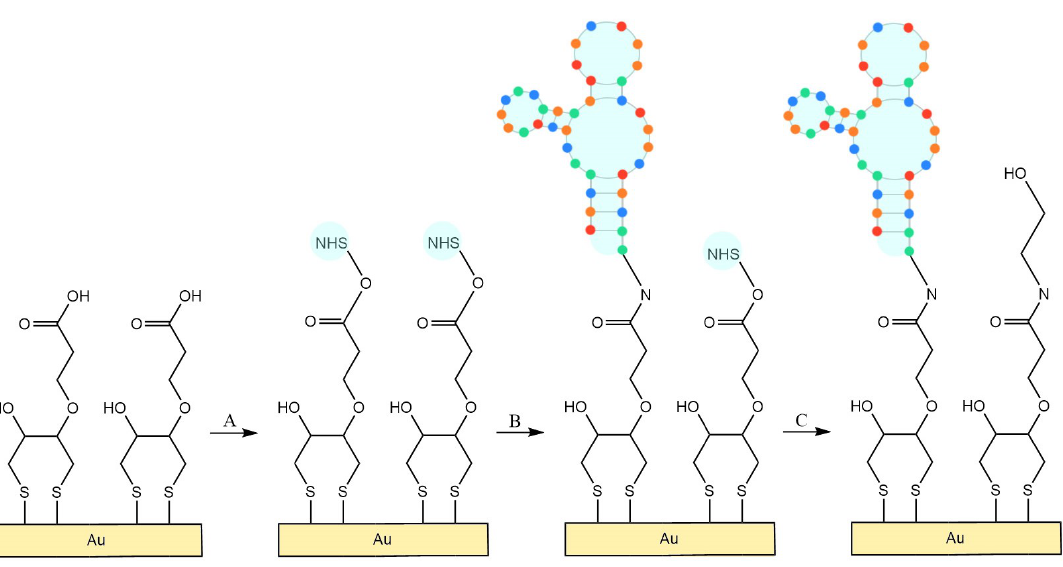
Figure 7. Surface modification of QCM crystals. Following DTT COOH , the crystals were functional- ized with β -mercaptoethanol (not shown), then (A) NHS/EDC, (B) aptamer, and (C) ethanolamine. Before measurements, the SAM-functionalized crystals were gently dried under a flow of